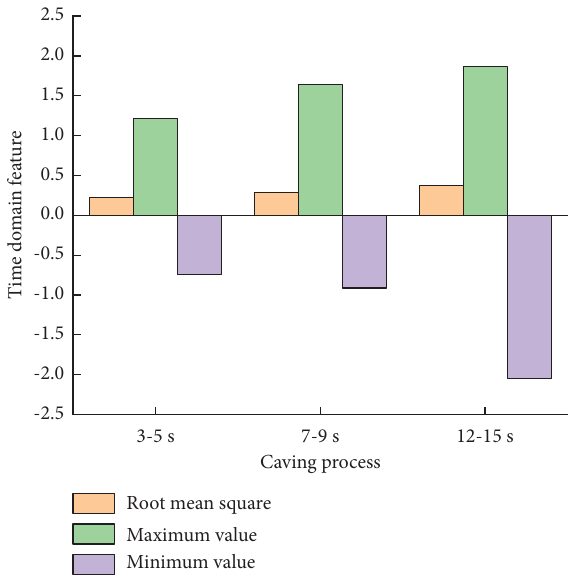
Figure 13: Time-domain signal characteristics of the three